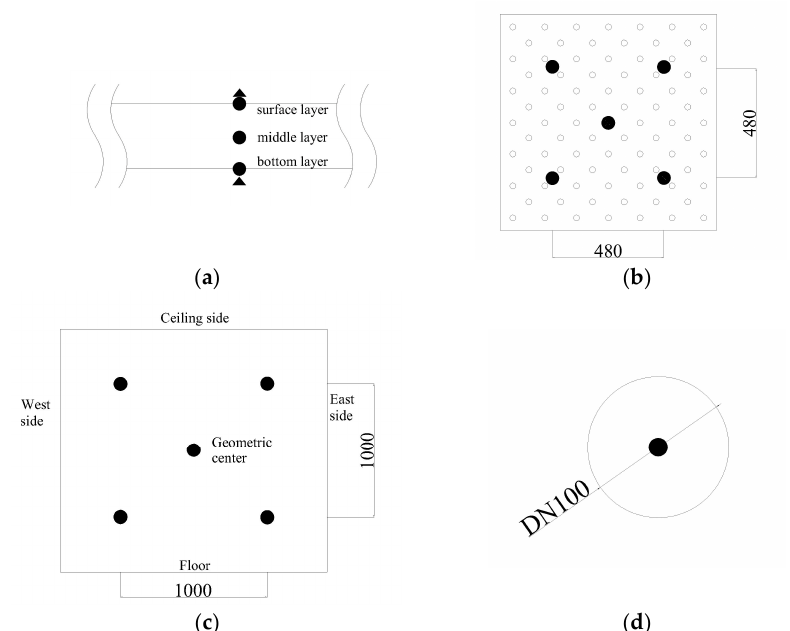
Figure 6. Arrangement of measured points. ( a ) Arrangement of measured points in PCM plate (along the thickness direction), ( b ) arrangement of measured points in PCM plate (middle layer), ( c ) arrangement of measured points in Room 1 and Room 2, ( d ) arrangement of measured point in ceiling inlet.